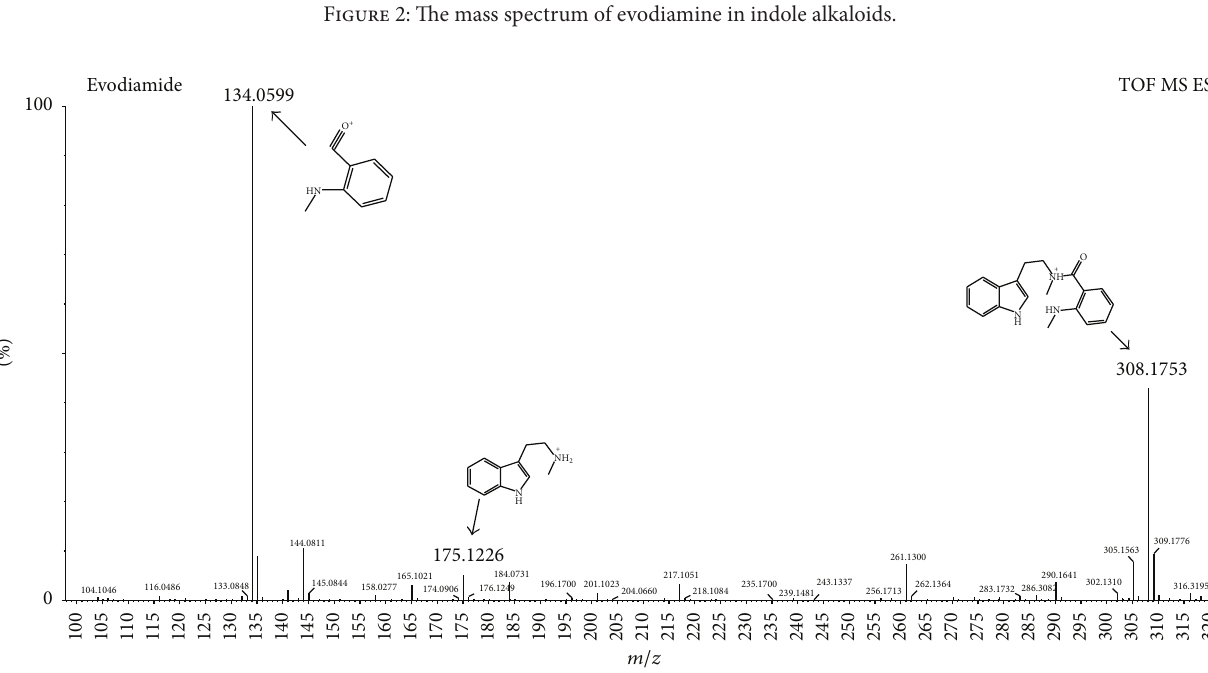
Figure 2: The mass spectrum of evodiamine in indole alkaloids.